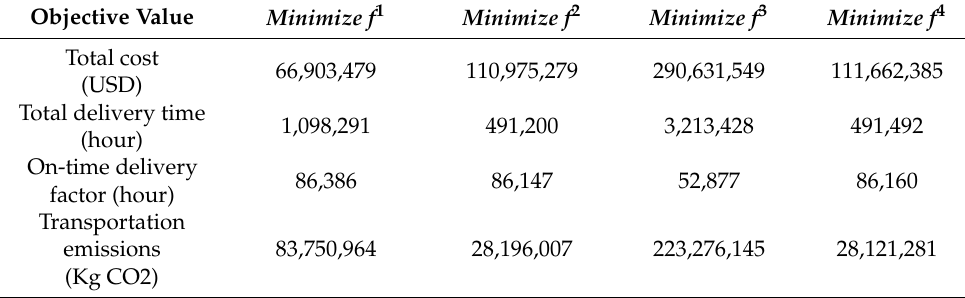
Table 8. Optimization runs.